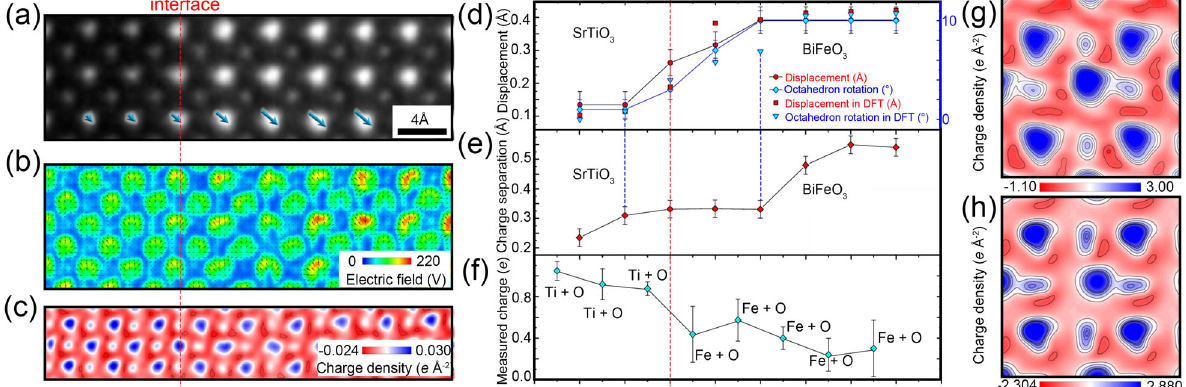
Fig. 9 4D-STEM applications to ferroelectricity. a A HAADF image from an STO-BFO interface; arrows indicate Bi displacement direction and magnitude. b , c The corresponding E- fi eld and charge-density maps were calculated from 4D-STEM data. d – f Analysis of the atomic structure ( d ), charge separation ( e ), and integrated B-site charge ( f ) determined from the HAADF image and charge-density map. g Charge-density image of bulk BFO from scanning diffraction experiments ( h ). Charge-density image obtained from DFT calculations. Reproduced with permission from ref. 73 . Copyright [2019] {Springer Nature}.